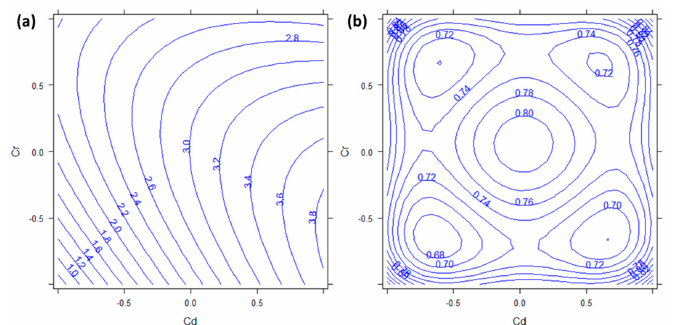
Figure 1. ( a ) Response surface and ( b ) semiamplitude of the 95% confidence interval for Cd response. Factors Cd and Cr are reported in abscissa and ordinate respectively. Pb has been kept constant to the 0 level.